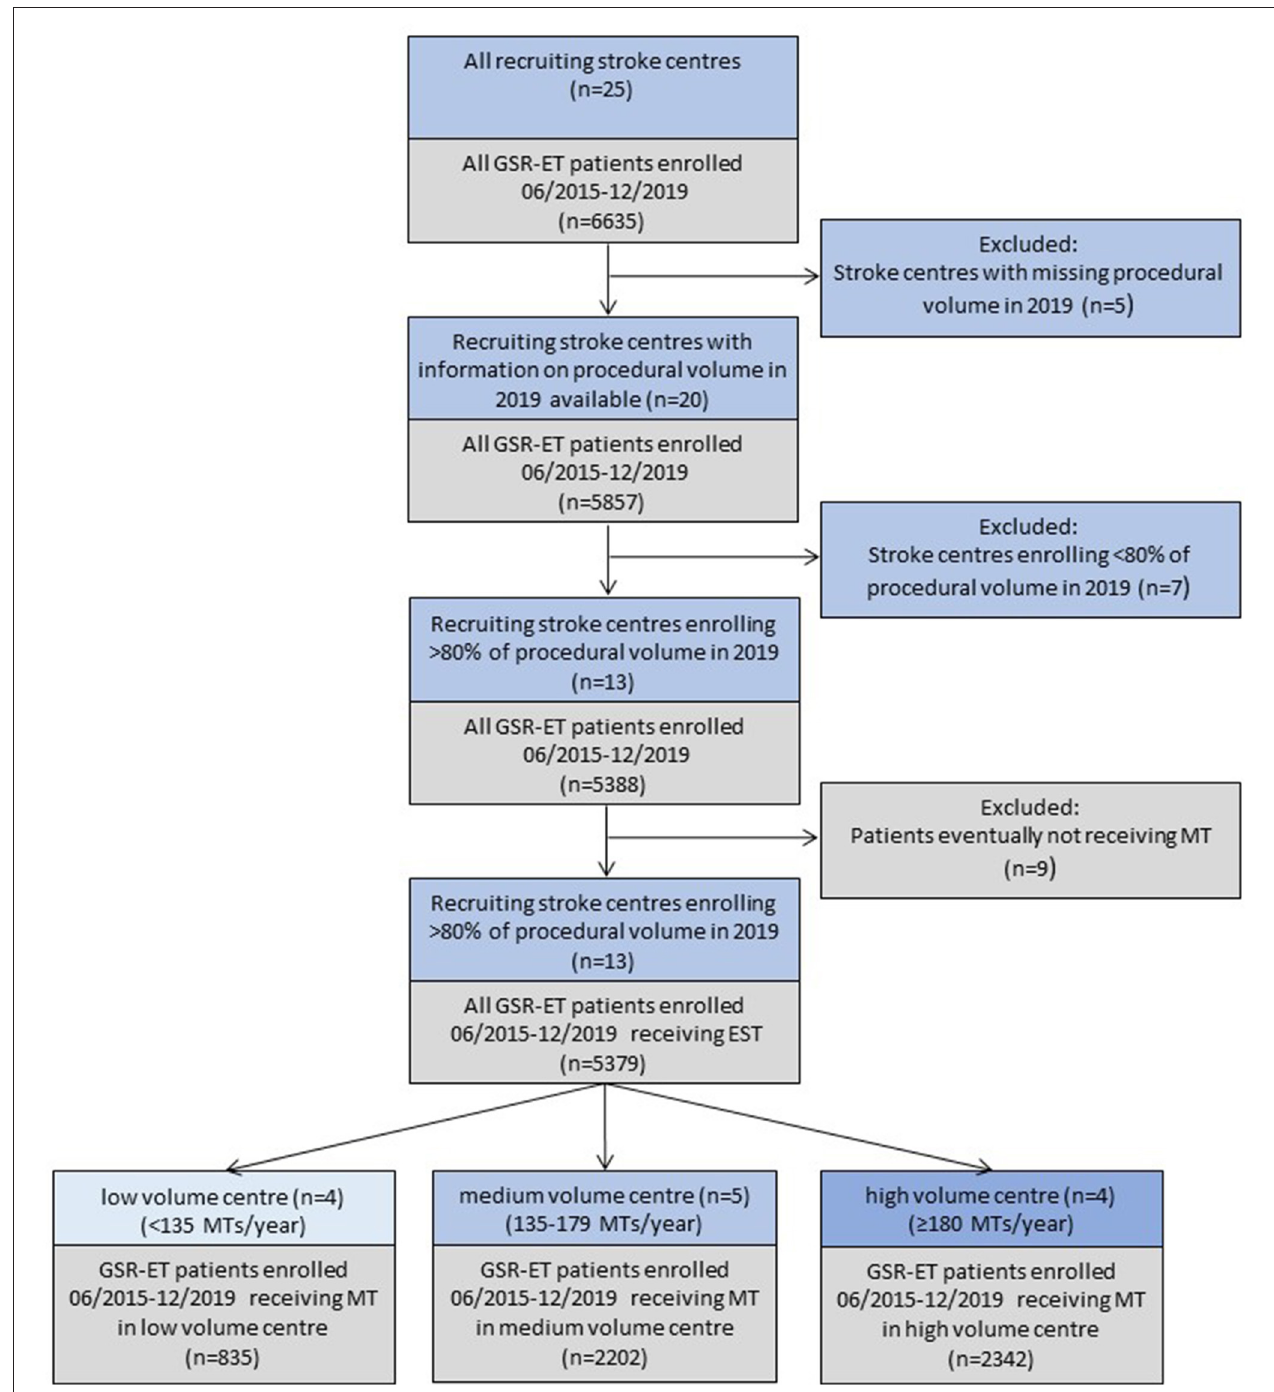
FIGURE 1 | Patient selection and comparison grouping. MT, mechanical thrombectomy; GSR-ET, German Stroke Registry Endovascular Treatment. Colors: blue: GSR-ET enrolling centers and center-specific exclusion criteria; grey: resulting patient cohort and patient-specific exclusion criteria.